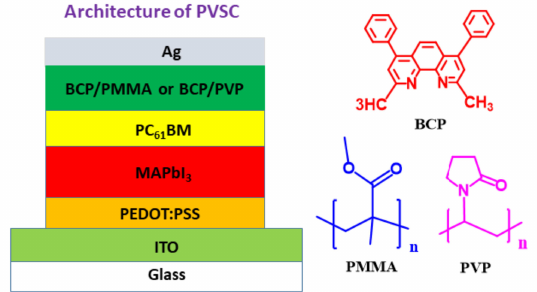
Figure 1. Architecture of the inverted perovskite solar cells